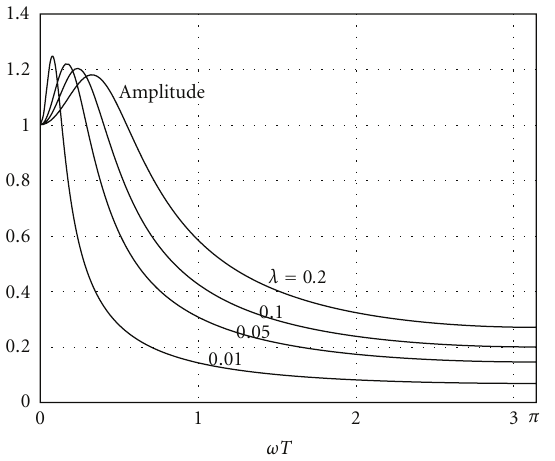
Figure 1: Amplitude frequency functions.